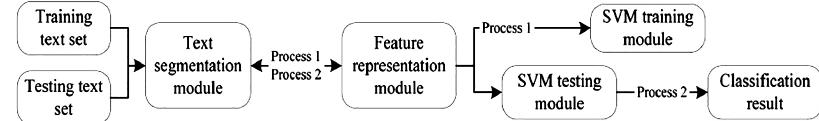
Figure 1. Framework of SVM Chinese text classification system by Zhang et al.